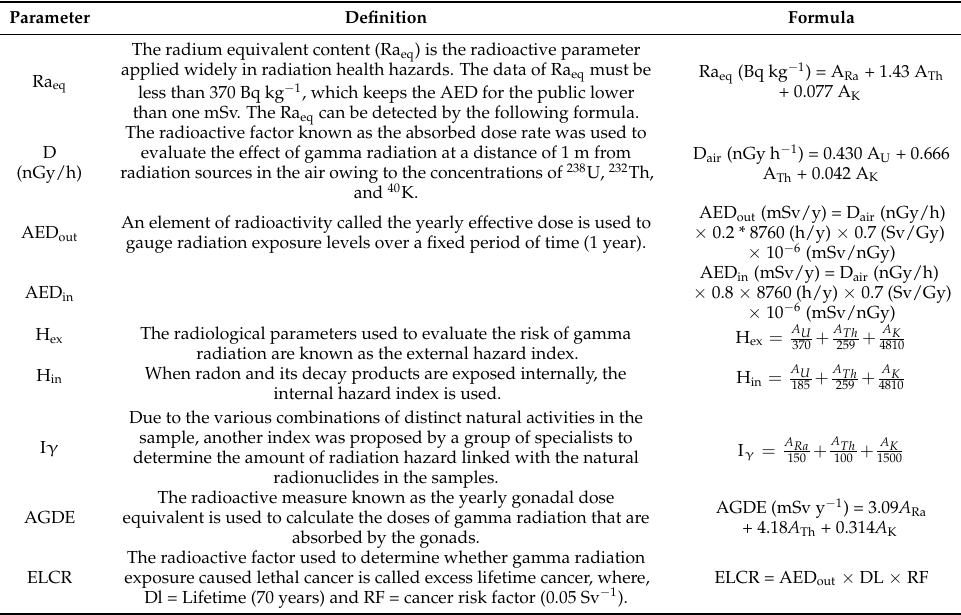
Table 1. Important radiological parameters and indices